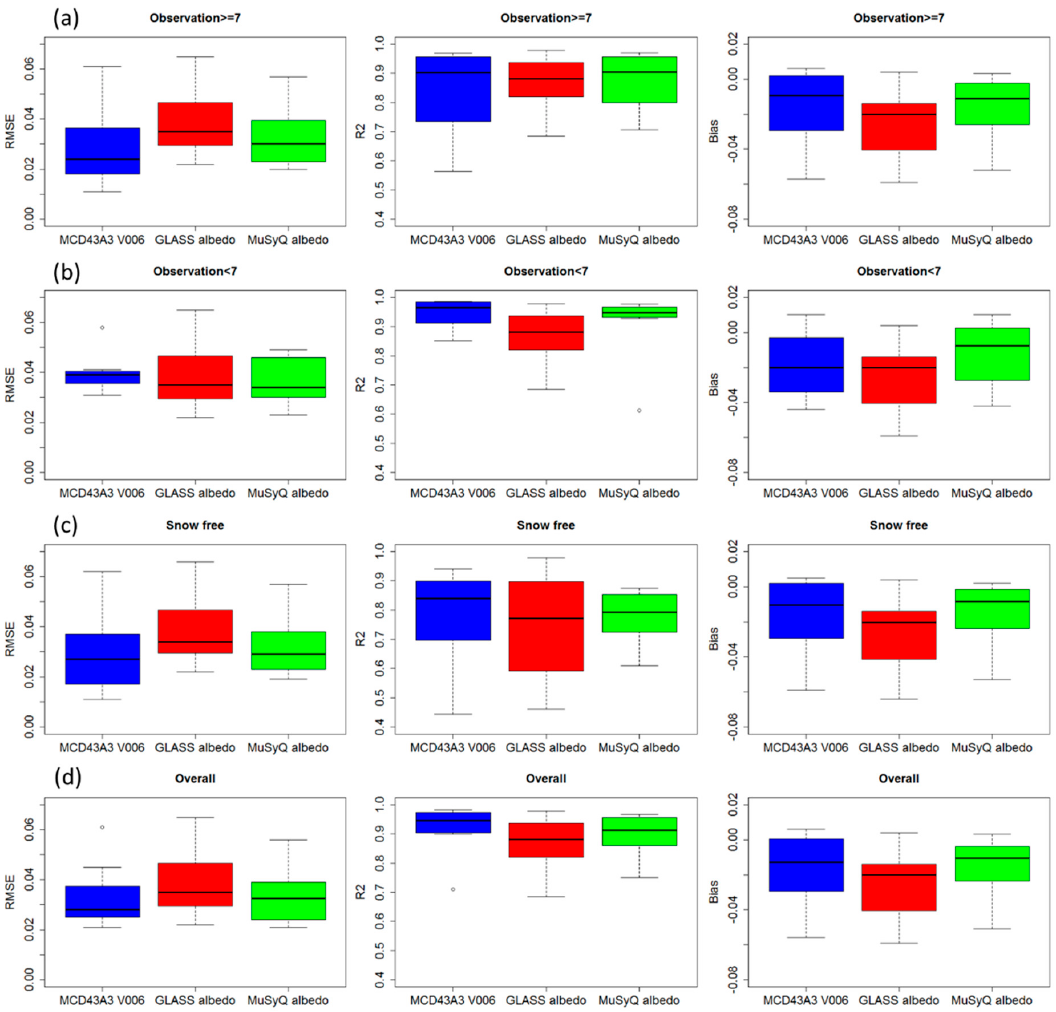
Figure 6. Box plots of the RMSEs ( left ), R 2 ( middle ), and Biases ( right ) from the direct comparison with ground-observed albedo in different inversion cases throughout the sites with small representativeness errors: ( a ) Observation ≥ 7, ( b ) Observation < 7, ( c ) Snow free, ( d ) Overall.